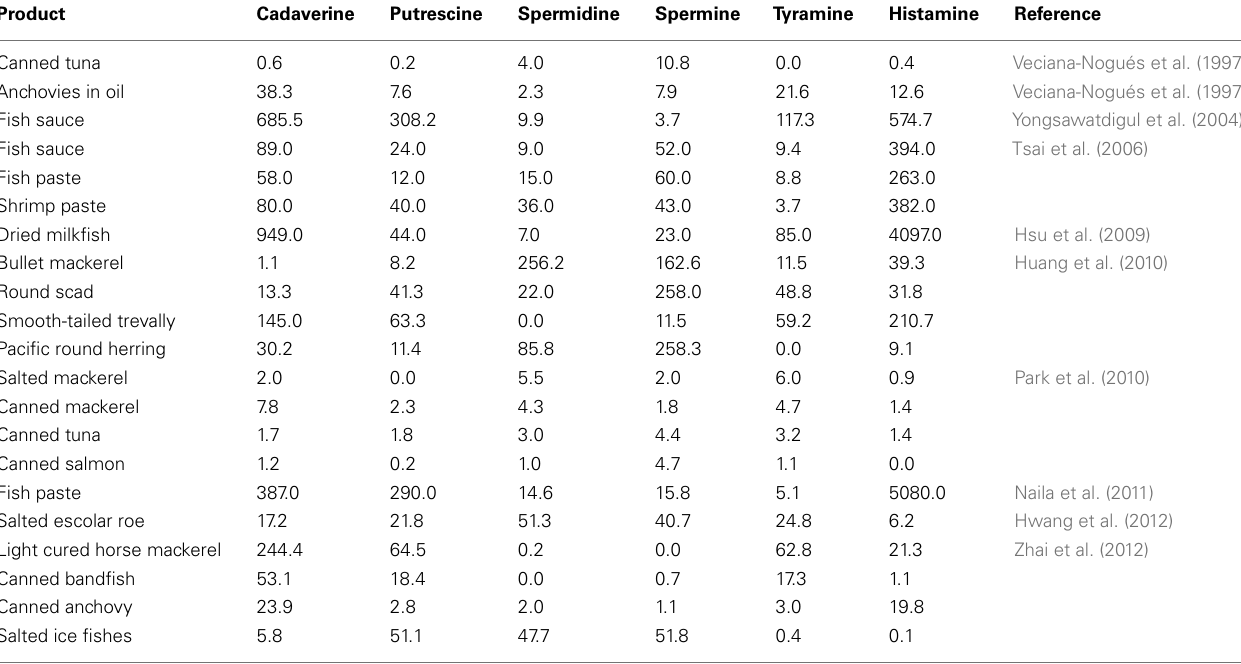
Table 3 | Levels (mean value, mg/kg) of BAs in processed